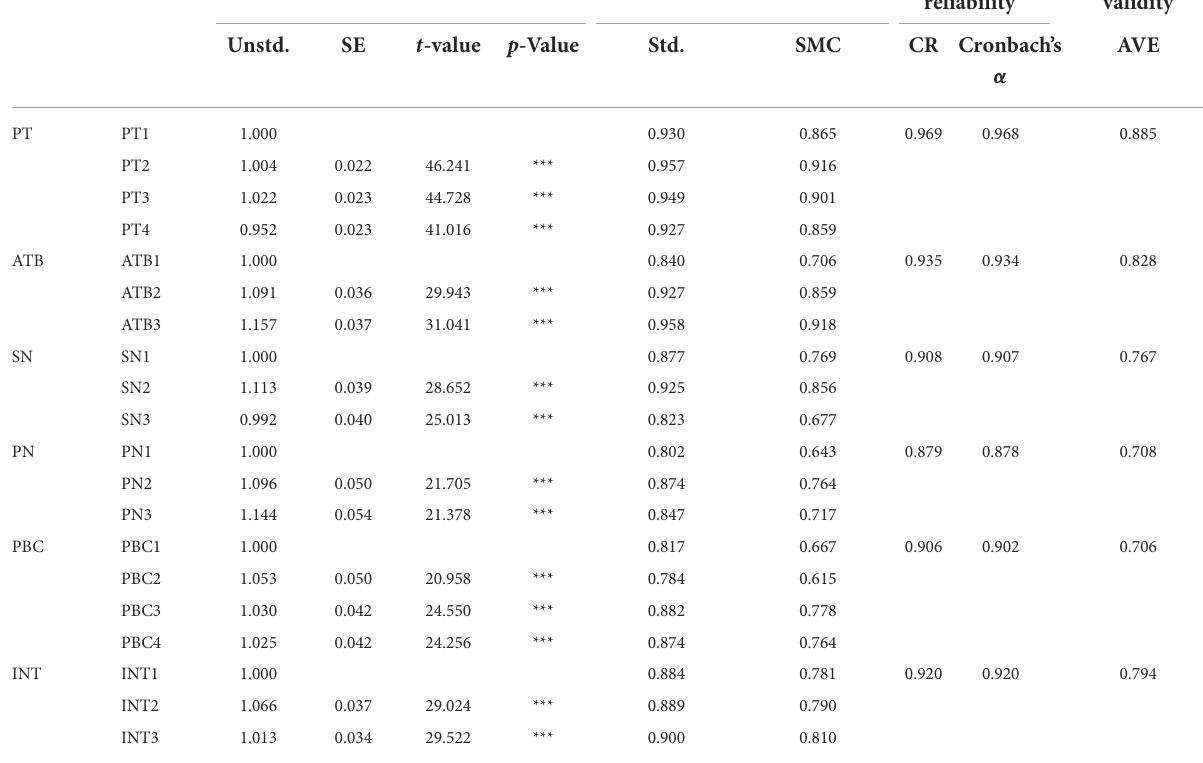
TABLE 4 Reliability and convergence validity